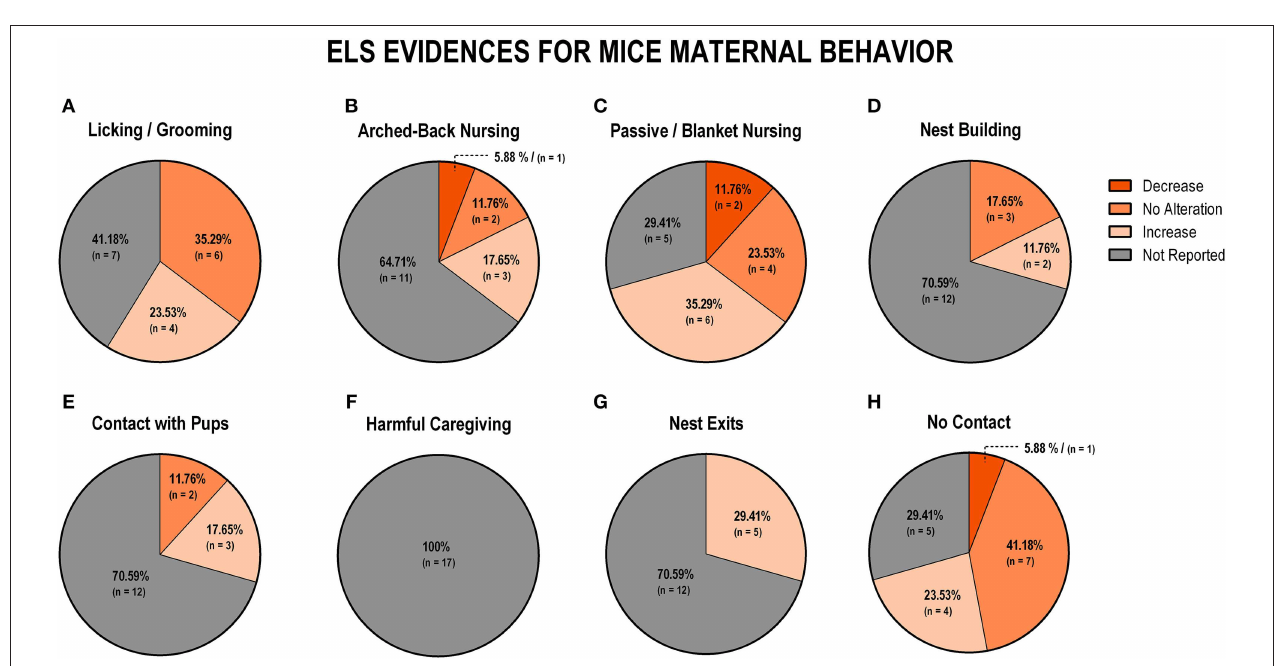
FIGURE 4 | Percentage of behavior findings from all mice studies. Licking and grooming behavior (A) . Arched-back nursing behavior (B) . Passive and blanket nursing behavior (C) . Nest building behavior (D) . Contact with pups behavior (E) . Harmful caregiving behavior (F) ; Nest exits behavior (G) . No contact behavior (H) .